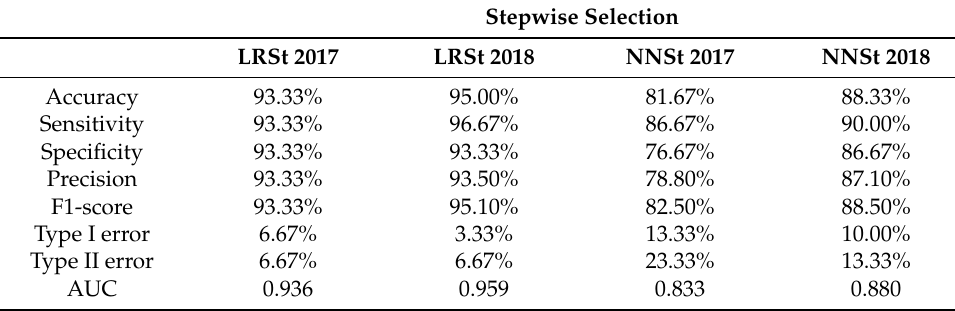
Table 9. Model performance metrics for stepwise selection